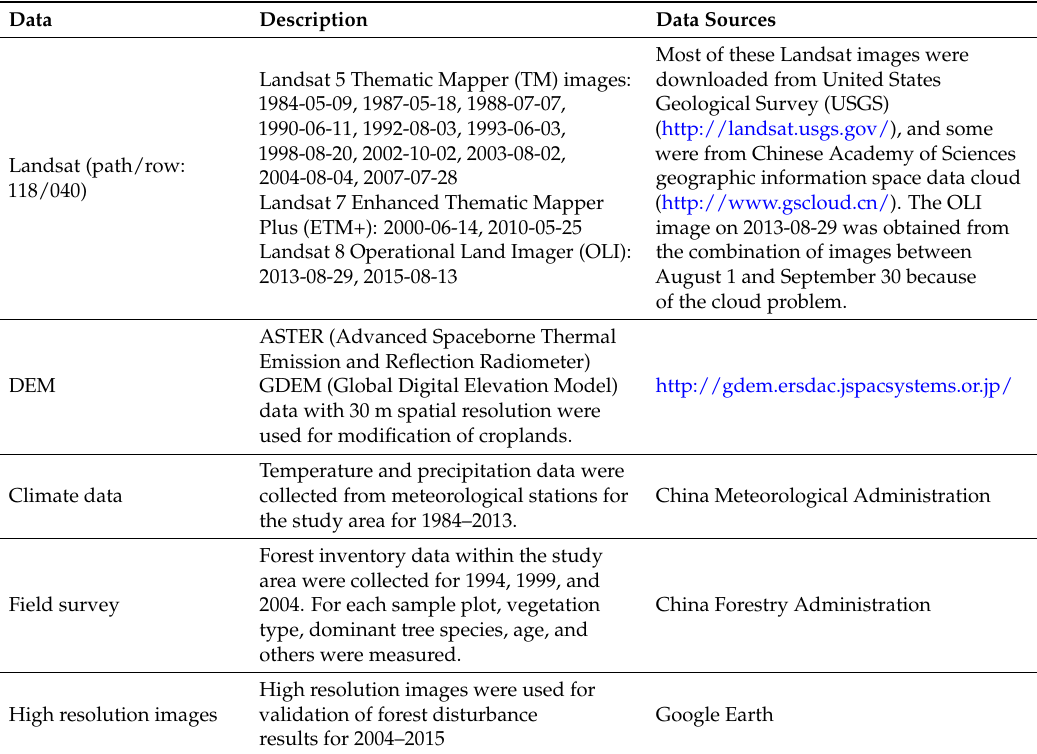
Table 1. Datasets Used in